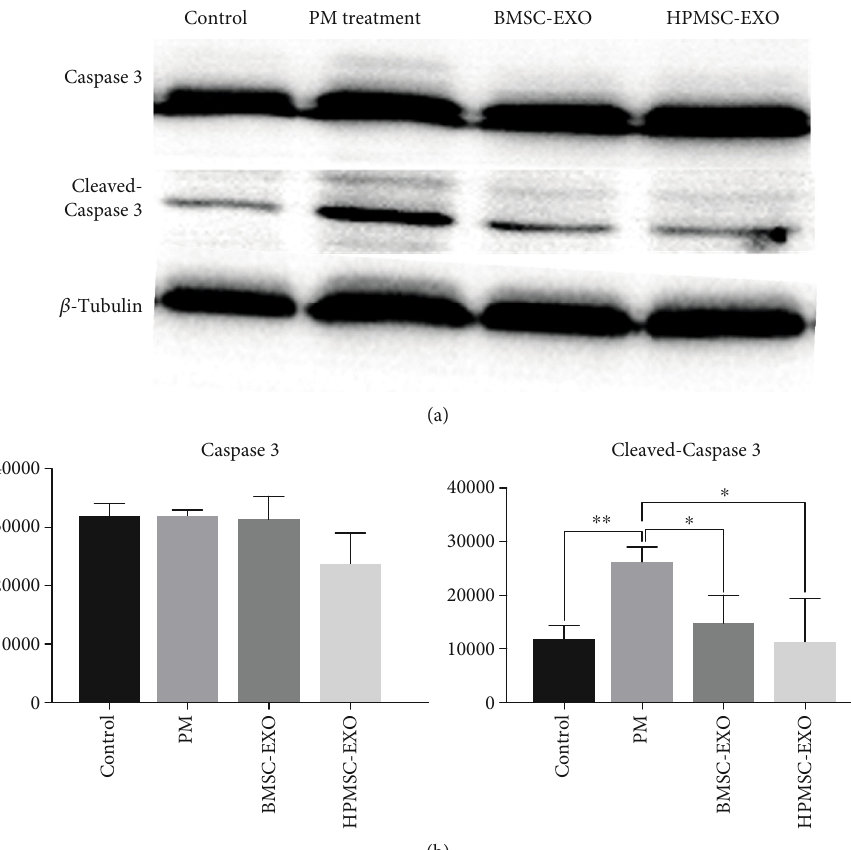
Figure 9: (a) Detection of di ff erences in the protein expression of apoptosis-associated Caspase 3 zymogen and cleaved-Caspase 3 in 4 groups of cells by Western blot. (b) Analysis of di ff erence in gray values. The di ff erences were statistically signi fi cant. ∗ P < 0 : 05 ; ∗∗∗ P < 0 : 001